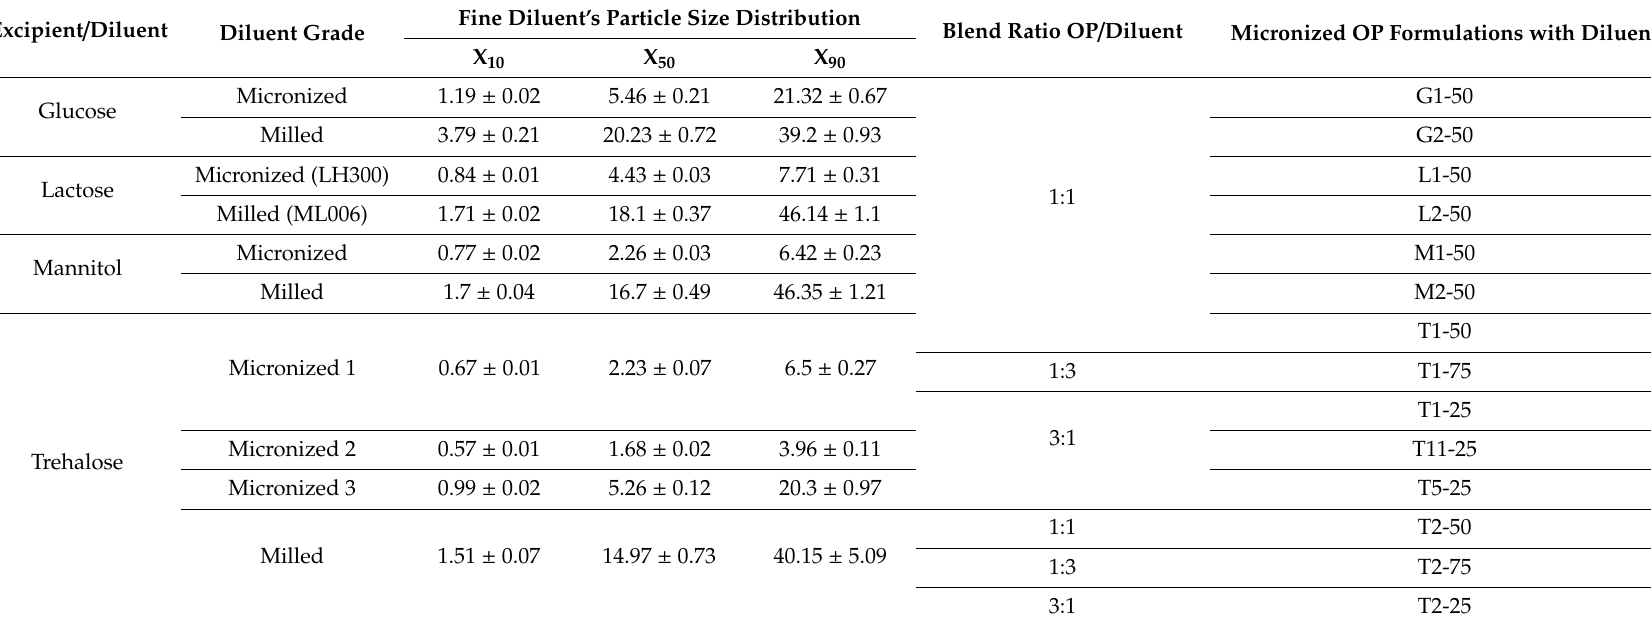
Table 1. List of all excipients’ grades (micronized or milled) showing particle size distribution as measured by laser di ff raction and set in di ff erent blending ratios with micronized Oseltamivir phosphate (OP) ( n ≥ 3, mean ±